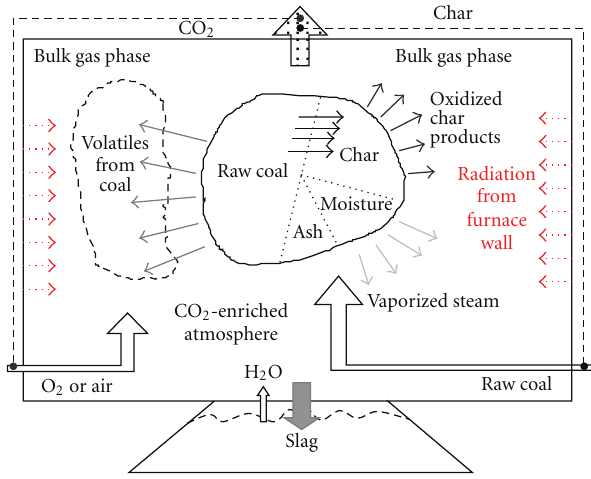
Figure 1: Schematic diagram showing reactions in coal gasification furnace